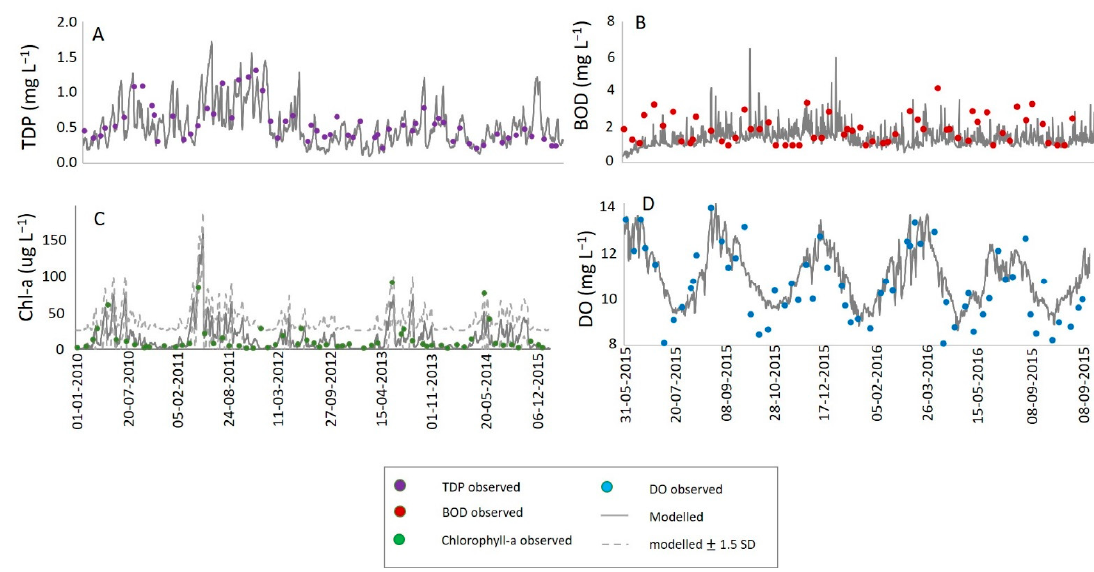
Figure 3. Calibration results of ( A ) TP concentration ( B ) TDP concentration, ( C ) chl-a concentration and ( D ) DO concentration in the Trent River between 2010 and 2015.